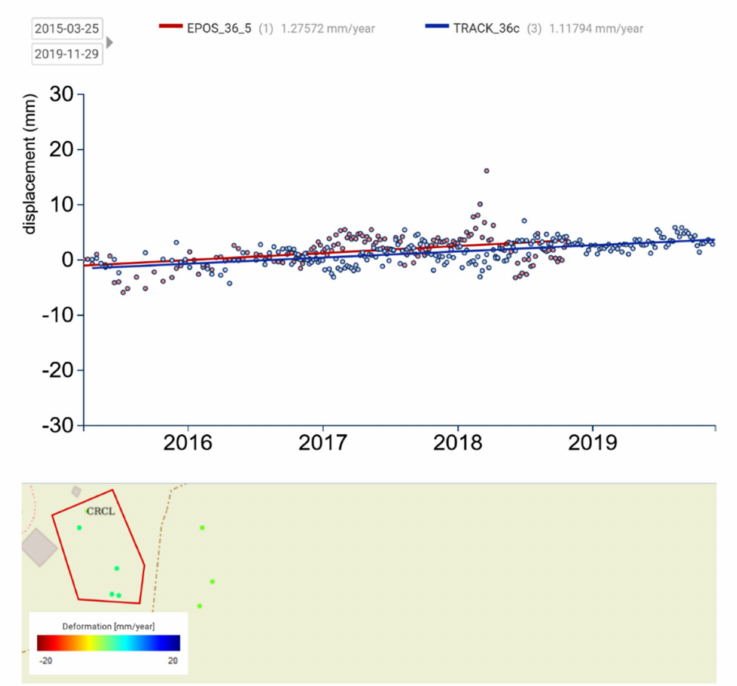
Figure 22. PSInSAR LOS trends: EPOS_36_5, 1.28 mm/year; TRACK_36c, 1.12